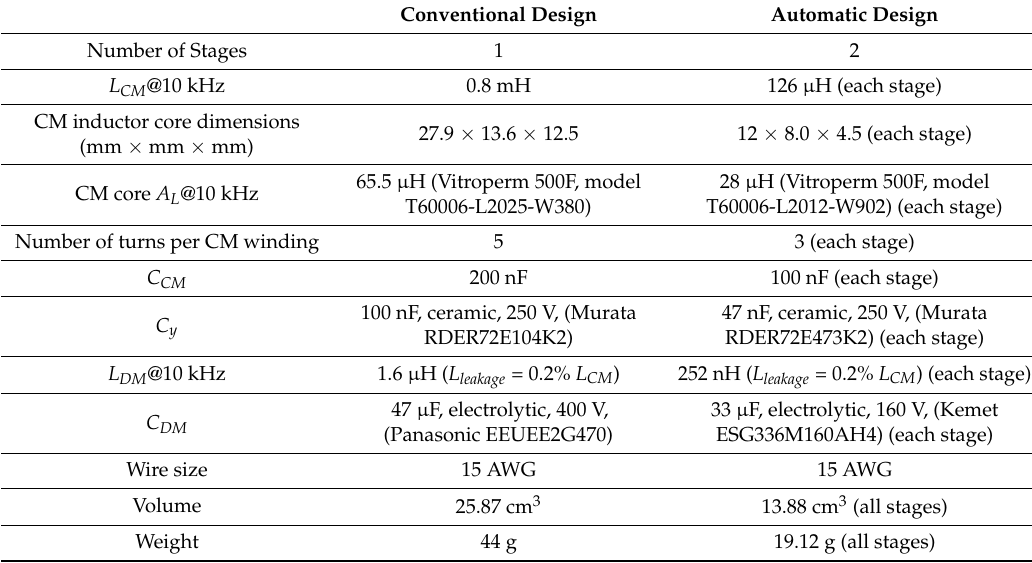
Table 3. Filter design output data–case study